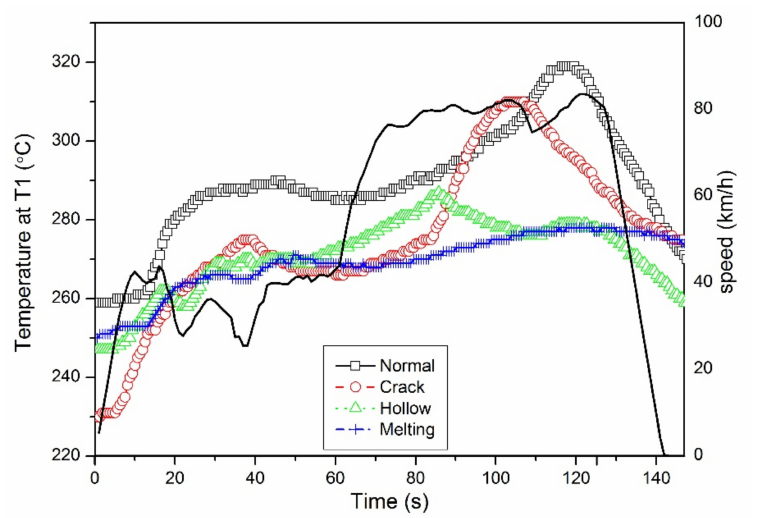
Figure 10. Temperature variation during KD-147 driving mode (black line) at position T1 in Figure